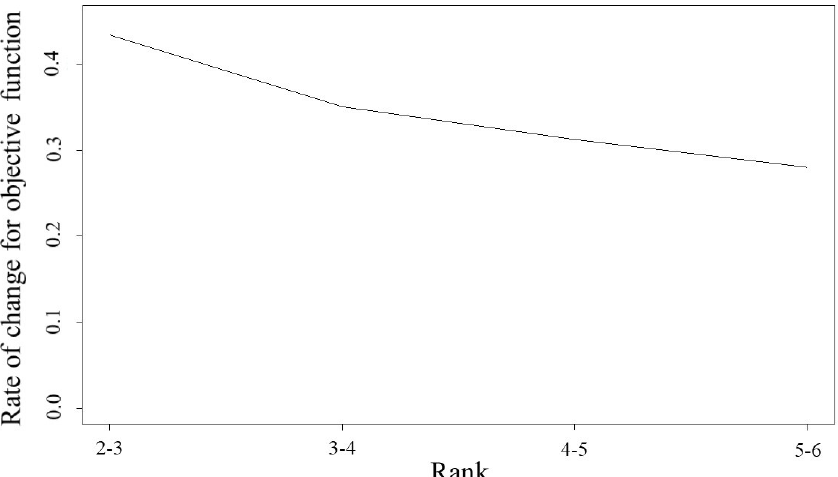
Figure 5. Change in rate for objective function; vertical and horizontal axes indicate rank and ratio of values for objective function,